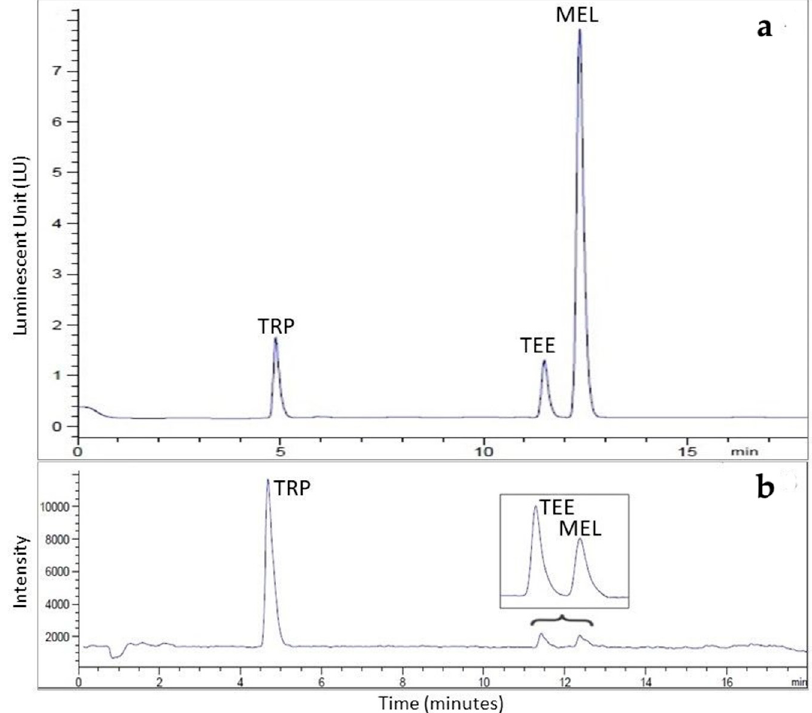
Figure 1. ( a ) HPLC-FL and ( b ) HPLC-MS chromatograms of tryptophan (TRP) (1 mg/L), tryptophan ethyl ester (TEE) (50 µg/L), and melatonin (MEL) (50 µg/L) in standard synthetic wine solution.